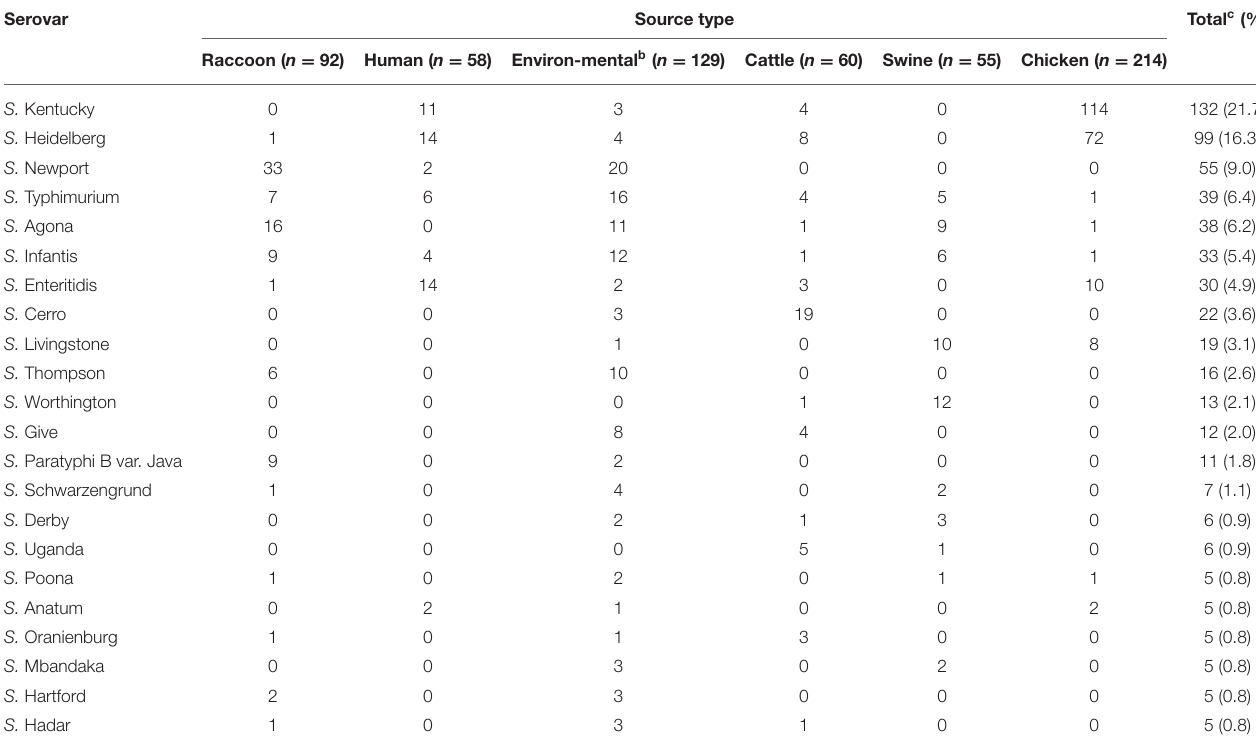
TABLE 1 | Distribution of Salmonella enterica serovars a from raccoons, humans, livestock, and environmental sources in southern Ontario, Canada 2011 – 2013 ( n = 608). Serovar Source